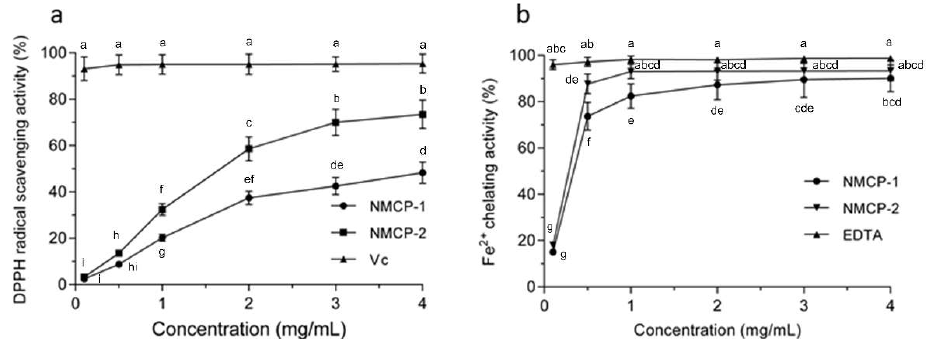
Figure 2. Antioxidant activity of NMCP-1 and NMCP-2 in vitro. ( a ) 2,2-diphenyl-1-picrylhydrazyl (DPPH) radical-scavenging activity. Vc was used as a positive control. ( b ) Chelating activity on Fe 2+ . EDTA (Ethylenediaminetetraacetic acid) was used as reference standard. Results are presented as means ± standard deviations ( n = 3). Different superscripts (a–i) within the same figure are significantly different ( p < 0.05).